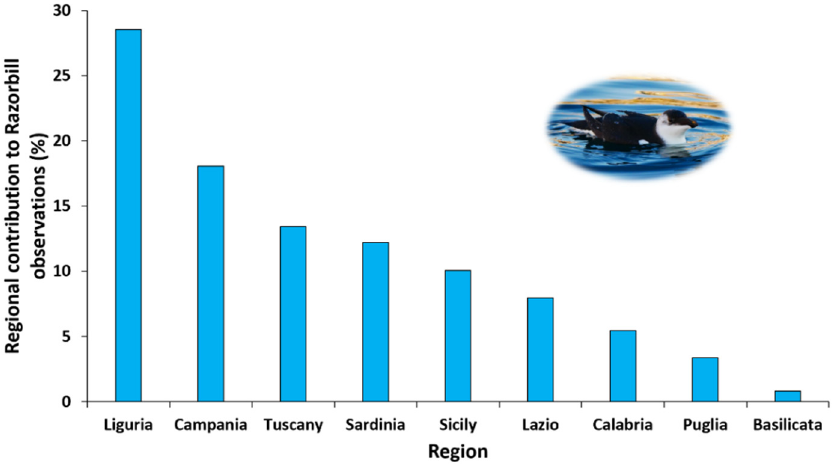
Figure 2. Regional contribution to razorbill observations expressed as percentage of observations over the total ( n = 238), for Italy (photo © Rosario Balestrieri).